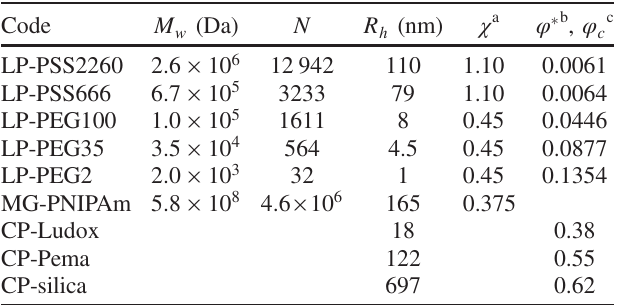
TABLE I. Molecular mass M , degree of polymerization N , w , and Flory parameter χ for the various hydrodynamic radius R h polymers and colloidal particles used in the viscous fingering experiments. The last column reports the overlap concentration φ (cid:3) , for the polymers, and the packing fraction φ where the zero- c shear viscosity appears to diverge, for the colloids.